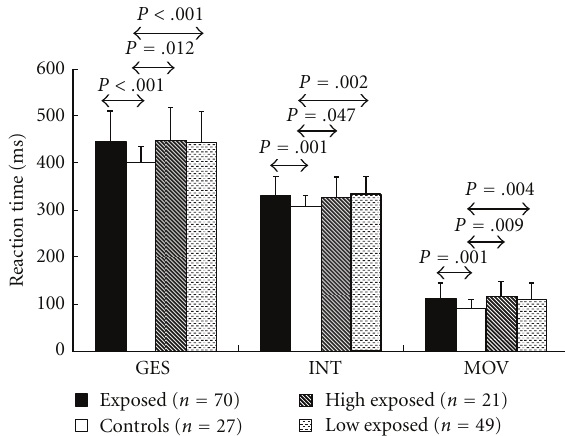
Figure 1: Mean values of total reaction time (GES), initiation time (INT), and movement time (MOV) of lead-exposed subjects (E) and controls (C) in the single-choice reaction task after visual